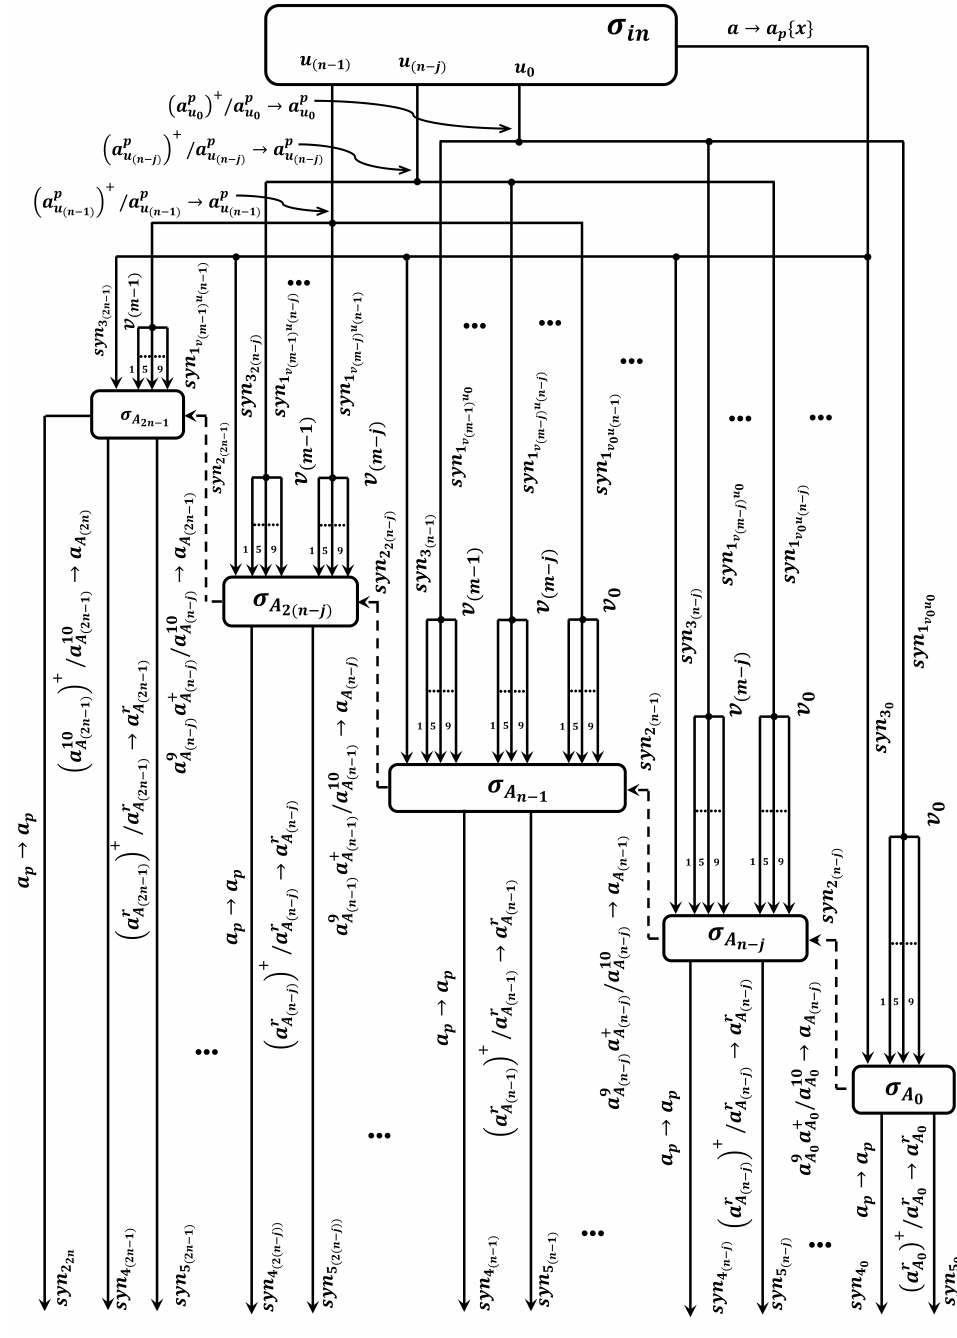
Figure 10. Structure of the neural